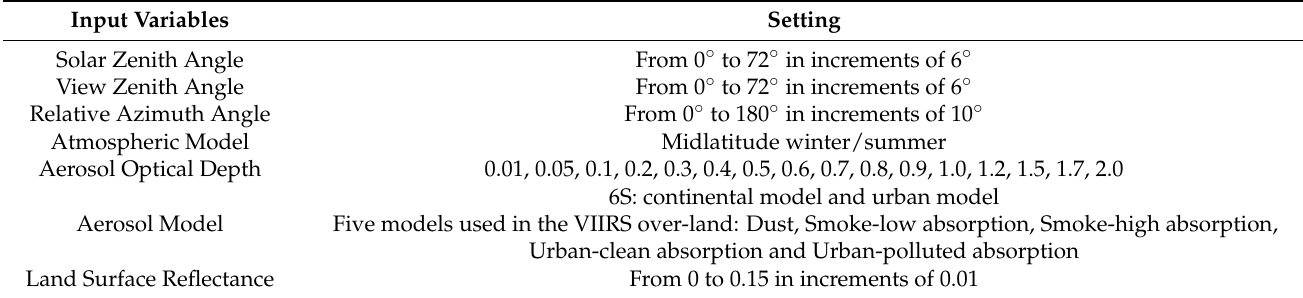
6S: continental model and urban